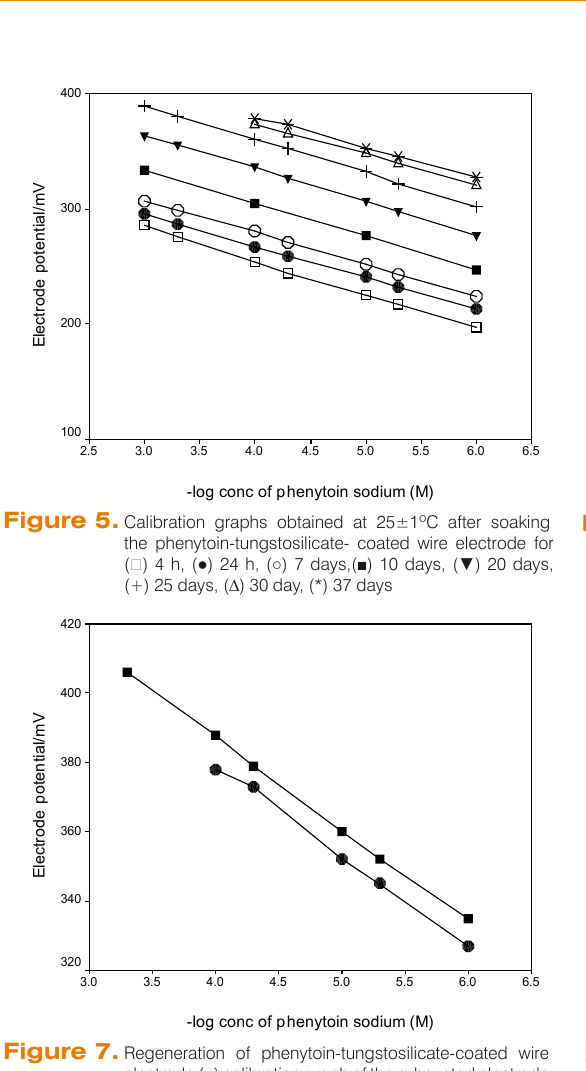
Figure 8. Effect of pH on potential/mV of 1.0×10 -3 M, ( ■ ) Plastic phenytoin-tungstosilicate-PVC electrode, ( ● ) Coated wire-phenytoin-tungstosilicate electrode